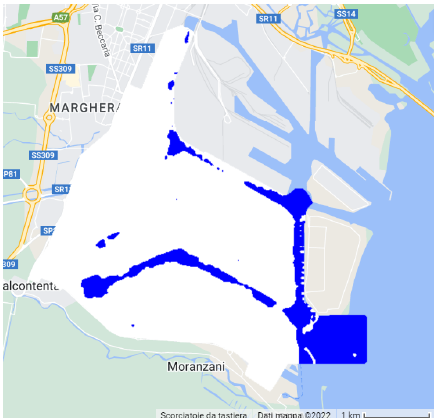
Figure 7. Water segmentation image obtained with the SAR approach using Sentinel